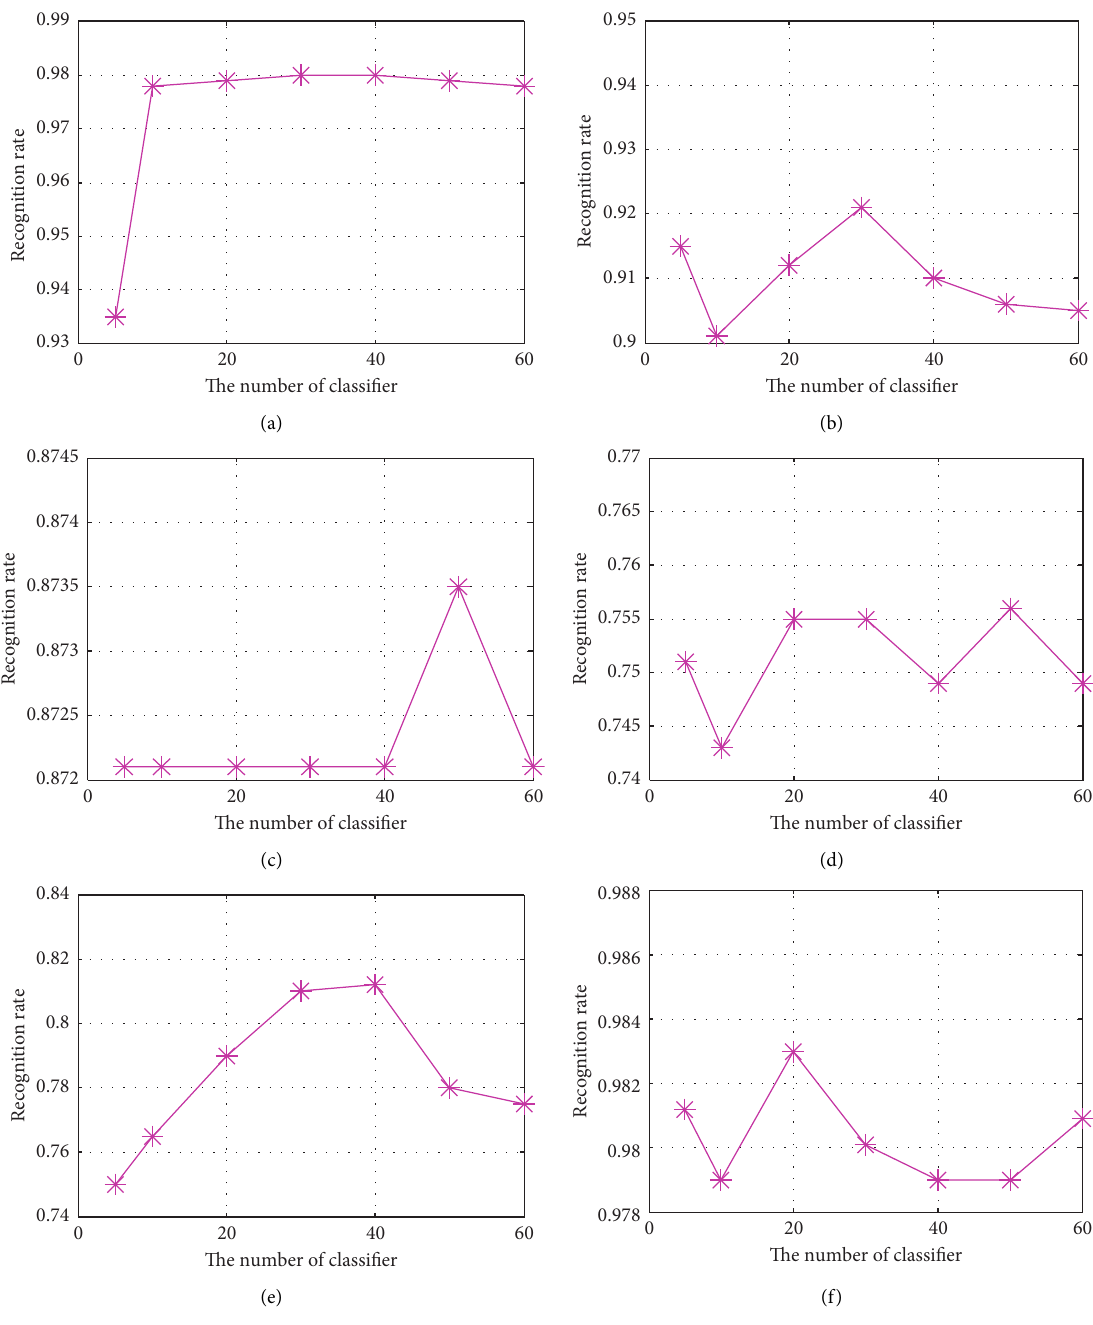
Figure 4: Experimental results: accuracy test of the classifier on the validation set. (a) Walk recognition rate. (b) Upstairs recognition rate. (c) Downstairs recognition rate. (d) Jump recognition rate. (e) Jogging recognition rate. (f) Stationary recognition